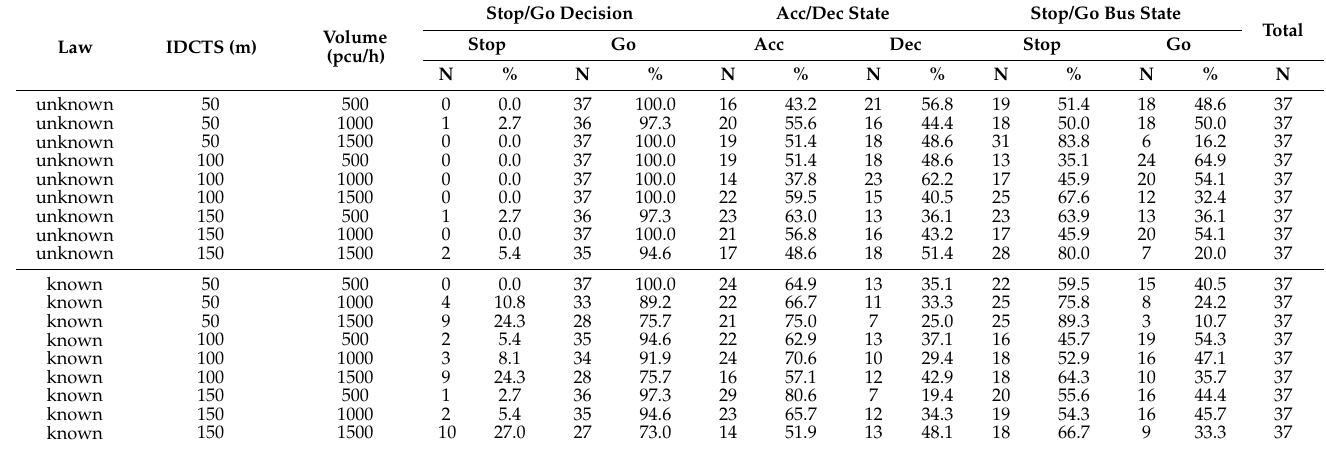
Table 1. Description for Stop/Go decision, Acc/Dec state, and Stop/Go bus state.